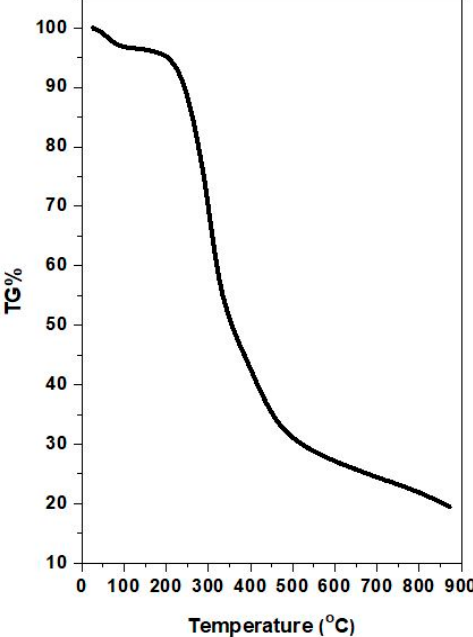
Figure 6. TGA thermogram of the produced AgNPs.